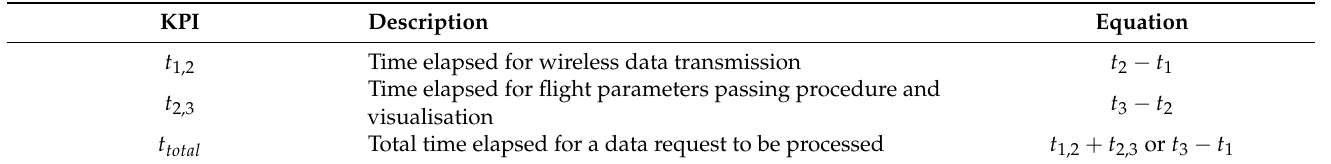
Table 3. Key performance indicators of system’s